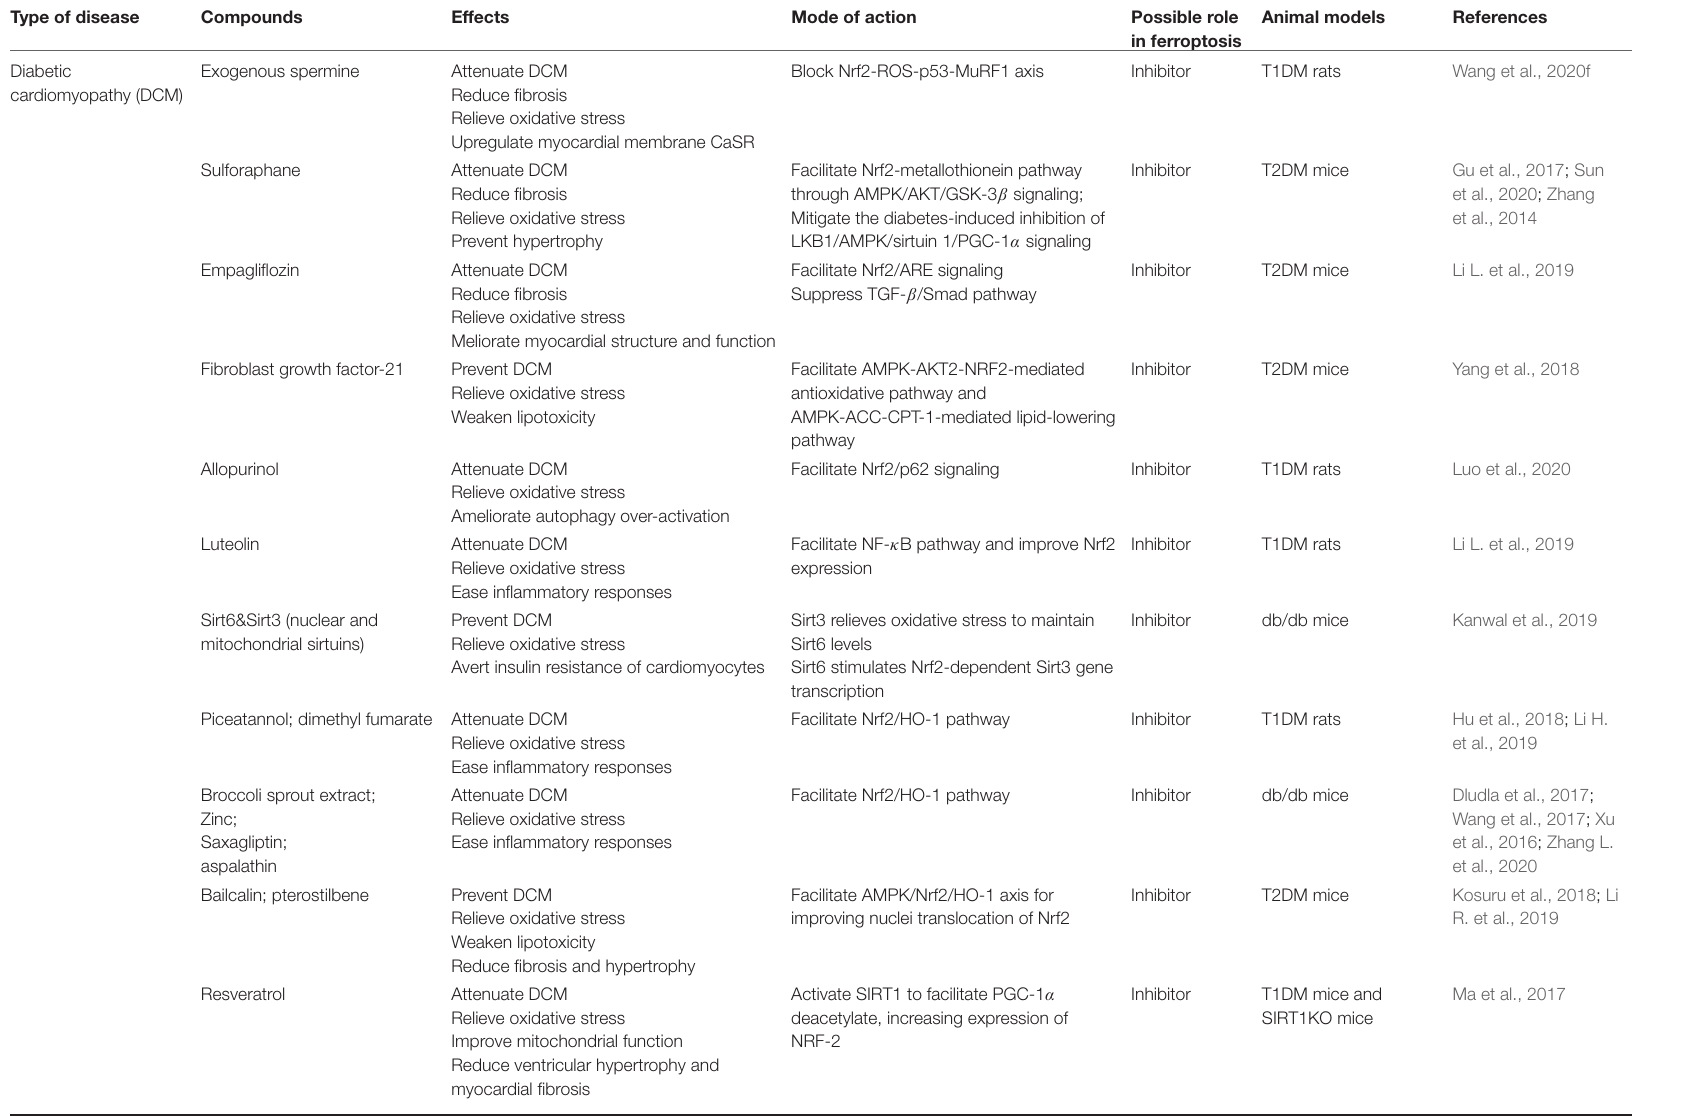
TABLE 1 | Emerging compounds targeted key regulators of ferroptosis to attenuate diabetic myocardial